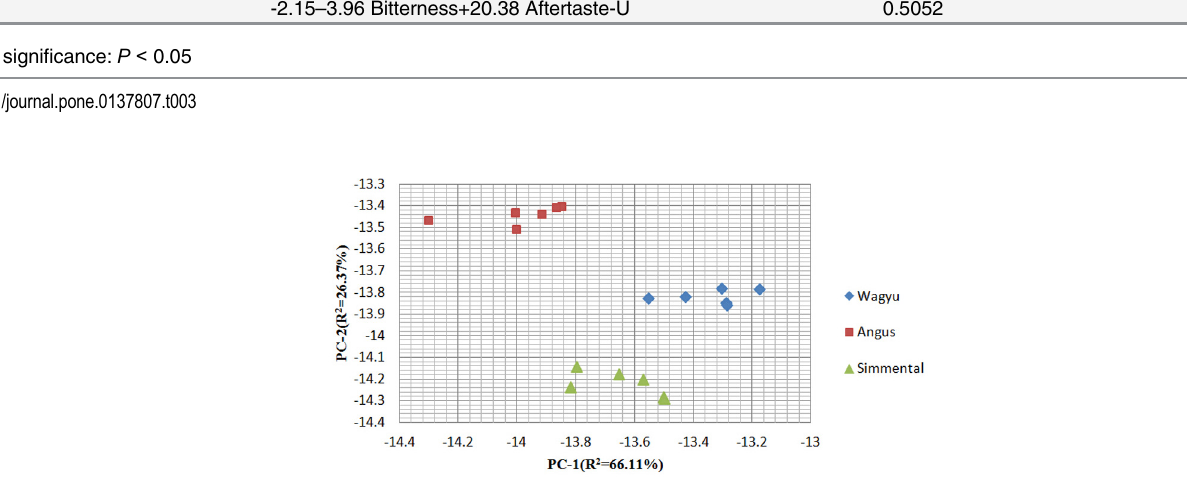
Fig 3. PCA score plot of different breed beef. The mean flavor values of the last three cycles were processed by PCA, which include sourness, umami, saltiness, bitterness, astringency, Aftertaste-B, Aftertaste-A and Aftertaste-U.